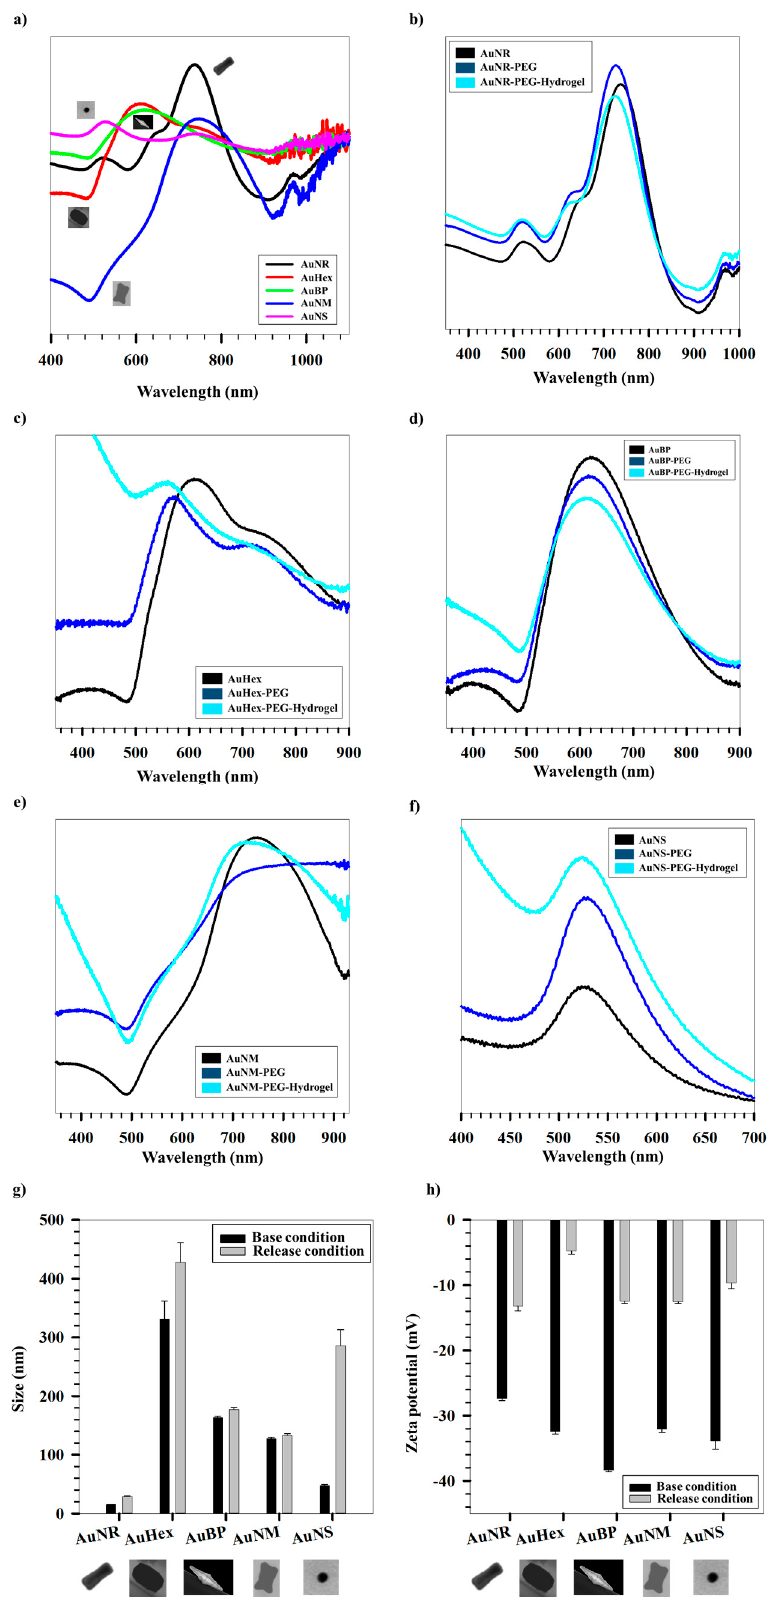
Figure 4. ( a ) UV-Vis spectra for differently shaped AuNPs. Variation of UV-Vis spectra after coating with PEG followed by hydrogel coating for ( b ) AuNR, ( c ) AuHex, ( d ) AuBP, ( e ) AuNM, and ( f ) AuNS. Variation of ( g ) hydrodynamic sizes and ( h ) zeta potentials of differently shaped AuNPs measured at base and release conditions, respectively.